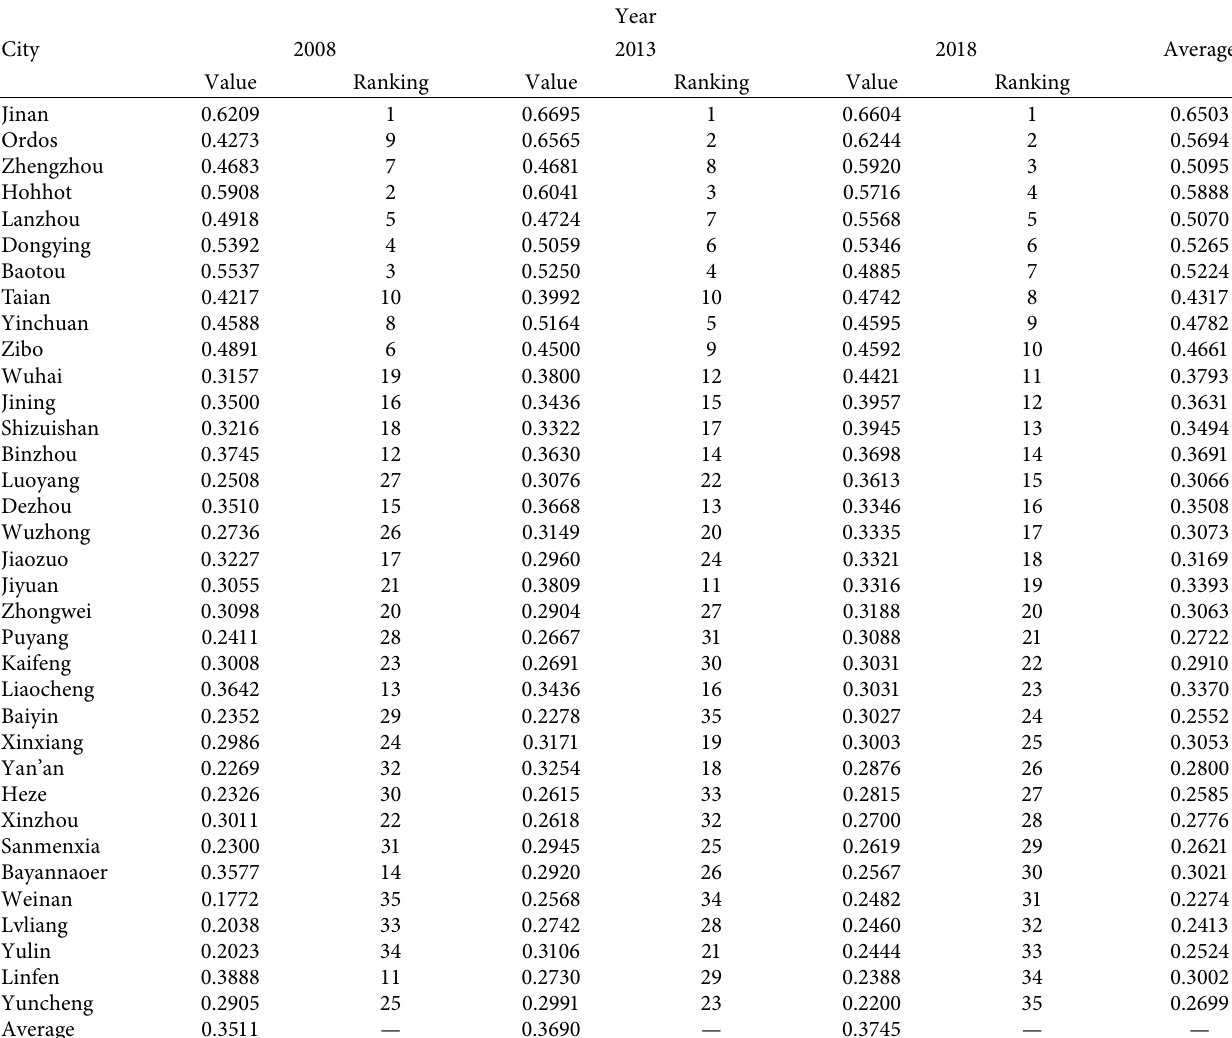
Table 2: The UGDI of cities along the